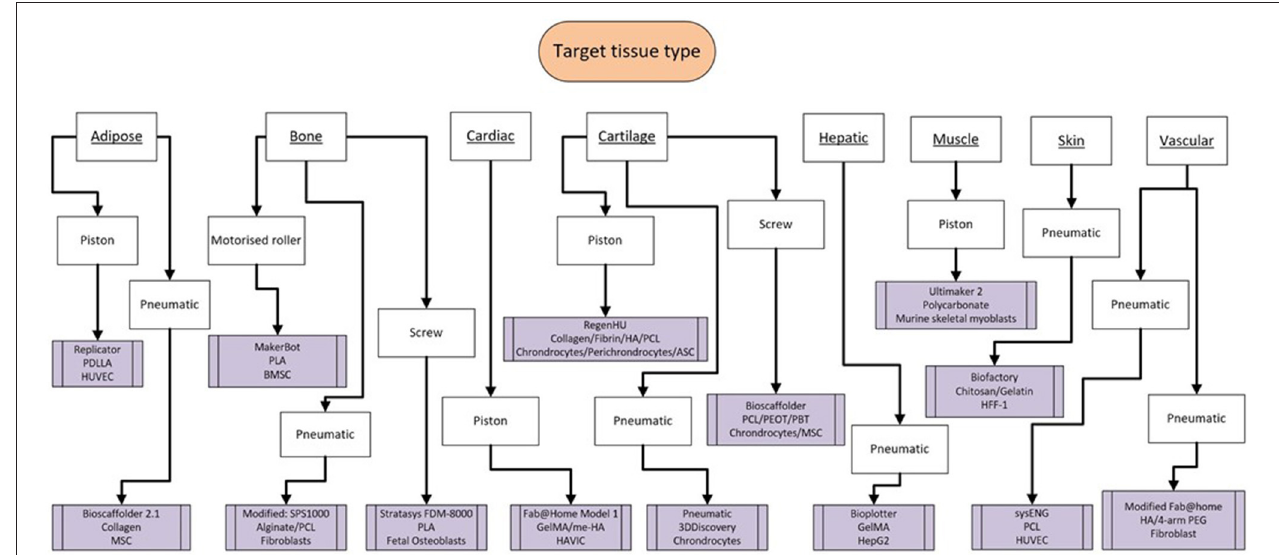
FIGURE 10 | Flowchart highlighting the scope of tissue type produced from the studies alongside the variability of bioprinter model, bioink, and cell